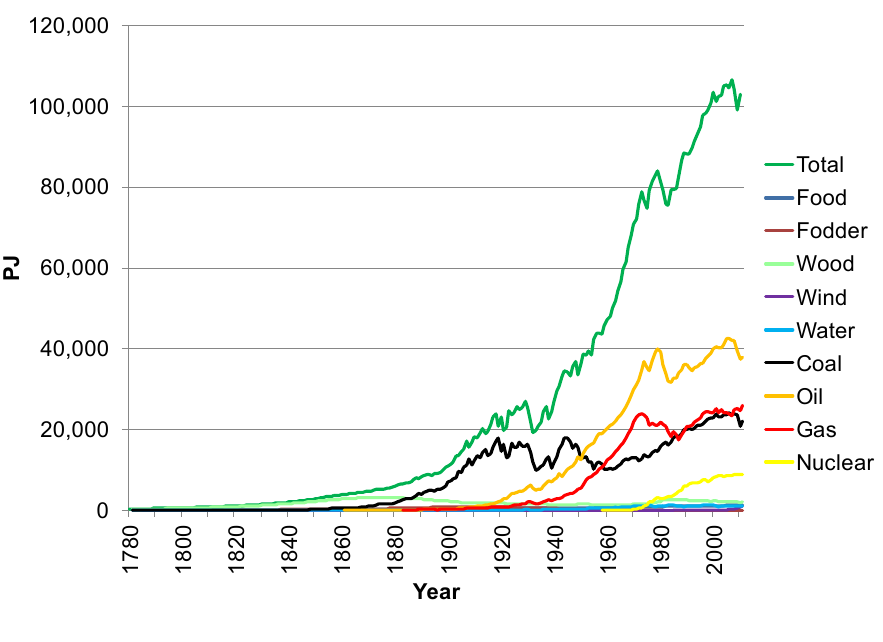
Figure 13. U.S. energy consumption, 1780–2010. Sources: various; see individual energy series in Section